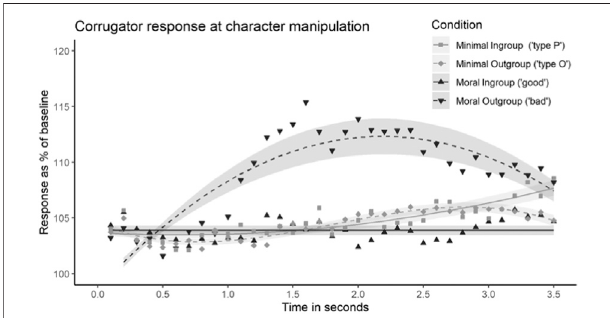
FIGURE 4 | Corrugator EMG response to the character manipulation. Dots show the observed data (averaged per 100 ms), and lines show the fi nal growth curve model (incorporating all intercept and trend parameters that signi fi cantly improved the model). The gray bands represent 95% con fi dence intervals from the fi nal growth curve